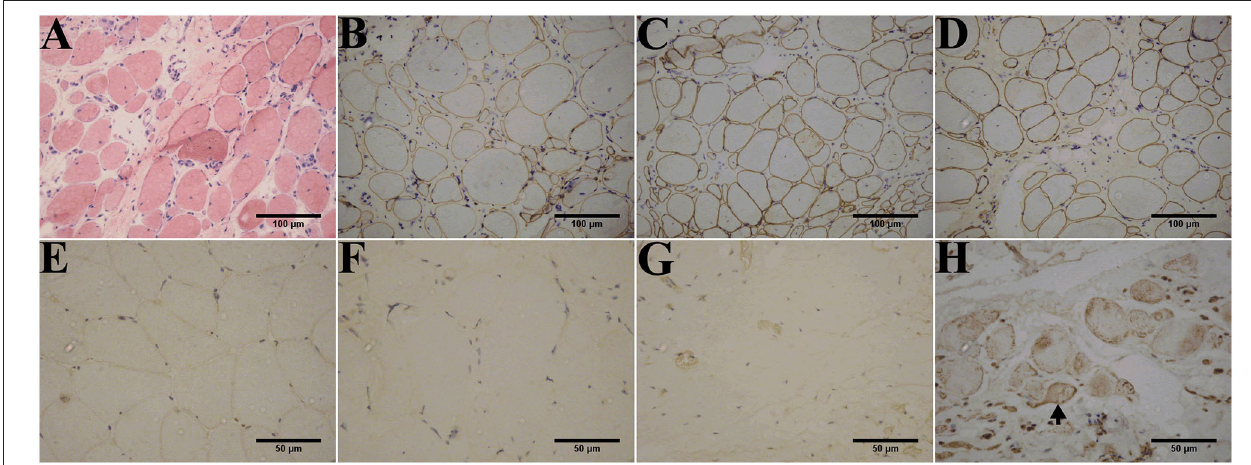
FIGURE 3 | Immunohistochemistry of dysferlinopathy patients. (A) H&E staining of muscle tissue from patient 1 showed myopathic or dystrophic alterations. Notice the increase of internal nuclei, variation in fiber size, endomysial mononuclear infiltration, and increase in inter- and intra-fascicular connective tissues. (B–E) Immunohistochemistry showed normal staining for DYS1 (B) , DYS2 (C) , and DYS 3 (D) in patient 1 and normal dysferlin staining (E) in a healthy individual. Immunohistochemistry indicated deficiency (F) or absence (G) of dysferlin expression in the sarcolemma and sarcoplasm from patients 1 and 2. (H) Aberrant aggregation of dysferlin in the sarcoplasm was detected in patient 3. Arrows point to fibers with positive dysferlin staining in the sarcolemma along with cytoplasmic dysferlin accumulation. The control muscle samples were taken from healthy individuals with informed consent who had undergone open fracture surgery as a result of a car accident.